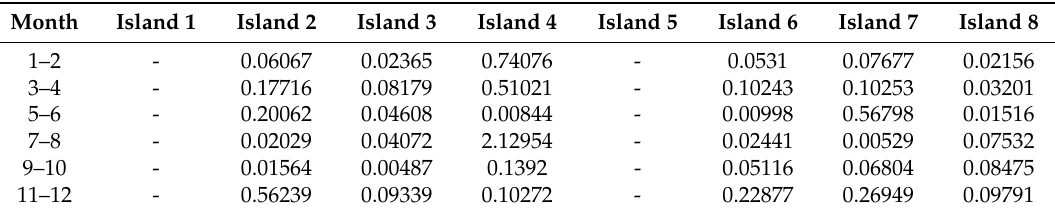
Table 3. Total squares of difference of normalized sum of power consumption by two month periods between Island 5 (to be estimated) and the rest of islands.